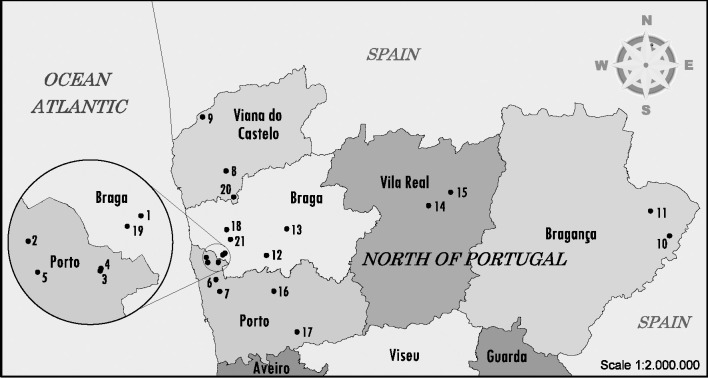
Map of North of Portugal showing the dairy farms sampled for STEC screening.The farm location and number of sampled animals can be consulted in S1 Table. Map was constructed using open data (public domain) from the Portuguese government that have Creative Commons Attribution 4.0 (CC BY 4.0) and was available at https://dados.gov.pt/pt/datasets/concelhos-de-portugal/ access on 12 February.